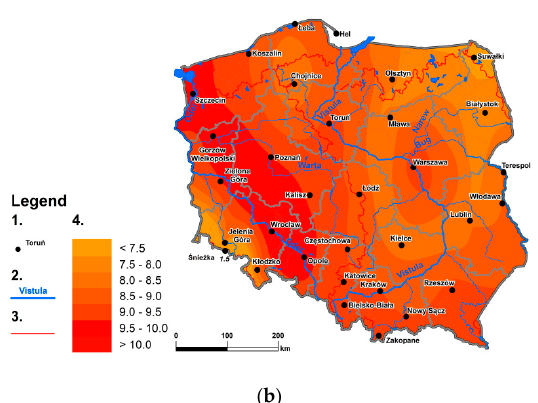
Figure 1. Spatial distribution of average amounts of precipitation ( a ) and air temperature ( b ) in Poland Institute data). Legend ( a ): 1—meteorological stations, 2—rivers, 3—river basin border,